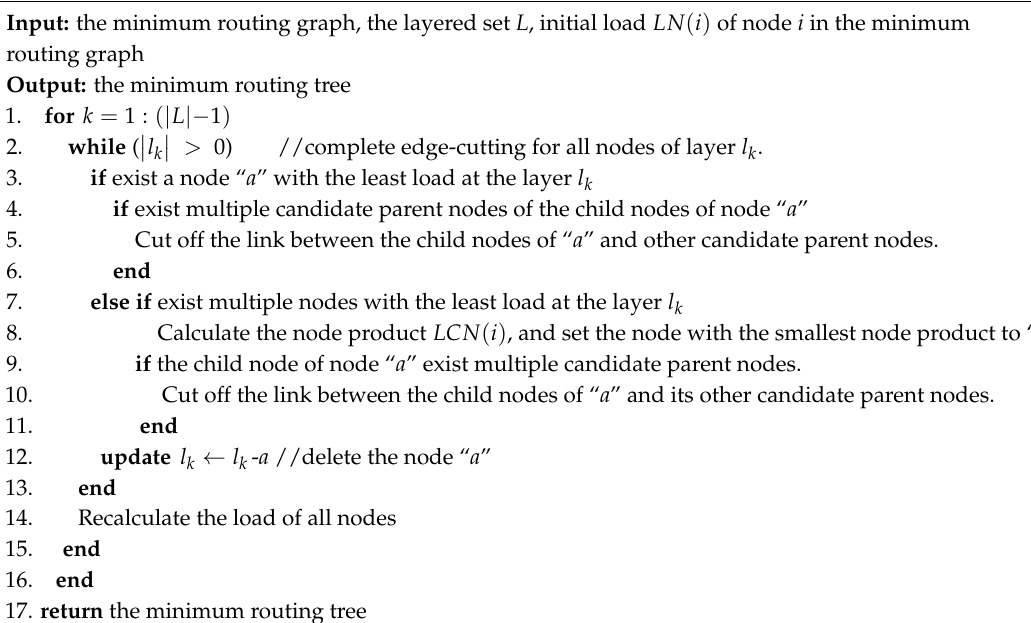
Algorithm 2 The Edge-Cutting